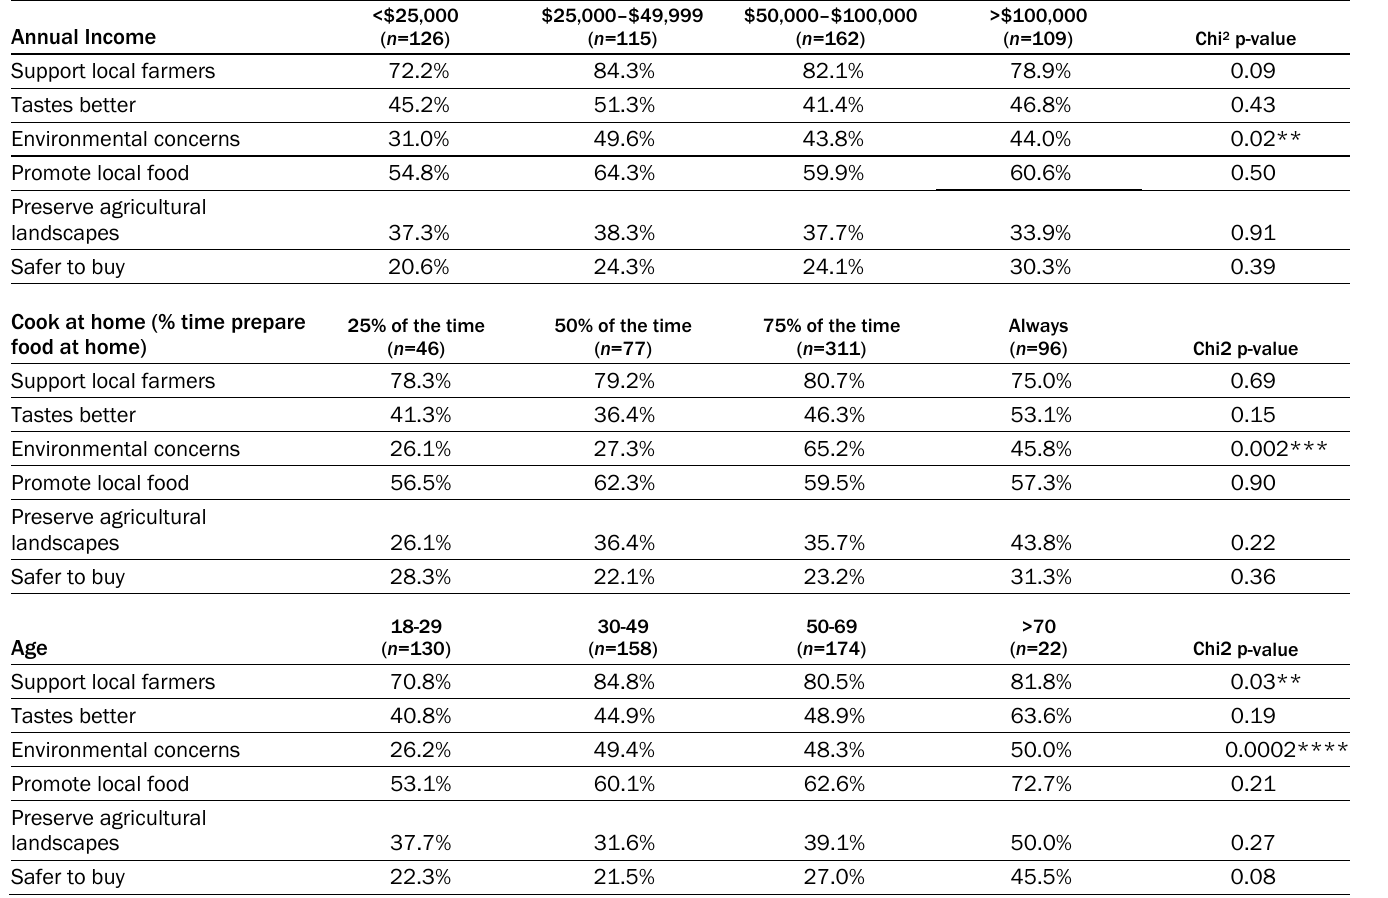
Table B1. Consumer Motivations for Buying Local Food, in Overall Rank Order, by Consumer Attributes (all income in